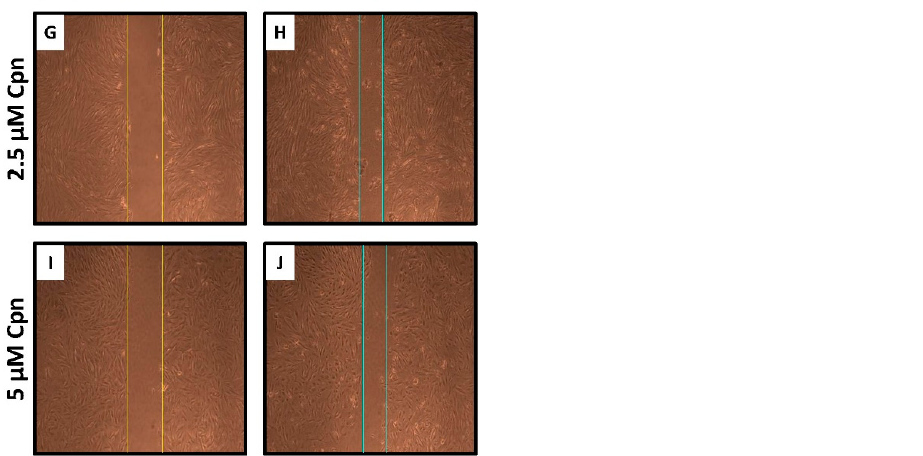
Figure 4. Wound healing scratch assay to assess the migratory ability of DPSCs treated with various concentrations of cordycepin (0.5 µM, 1 µM, 2.5 µM, and 5 µM). ( A – J ) Scratch assay. ( K ) Comparative analysis of percentage migration of DPSCs. ns not significant, ** p < 0.01. Cpn: Cordycepin.